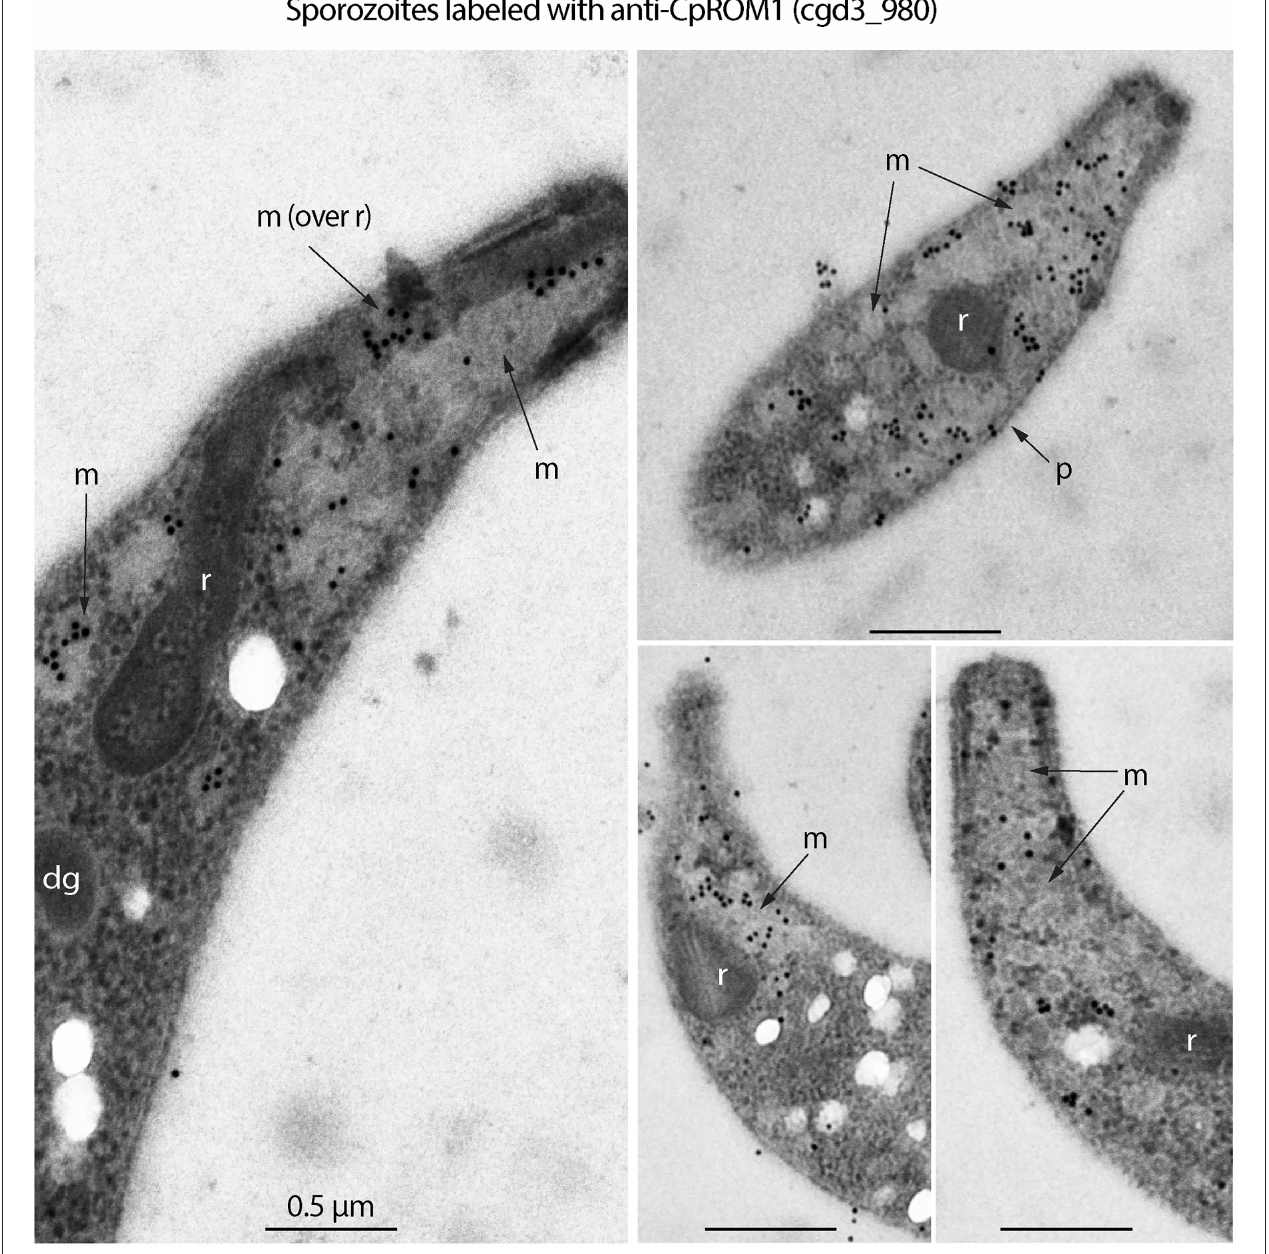
FIGURE 3 | Immunogold electron microscopy (IEM) labeling of CpROM1 protein (cgd3_980) in free Cryptosporidium parvum sporozoites showing major distribution of gold particles in micronemes (m) and minor distribution on the pellicle (p) as exemplified by arrows. There were no gold particles on other organelles such as rhoptry (r) and dense granules